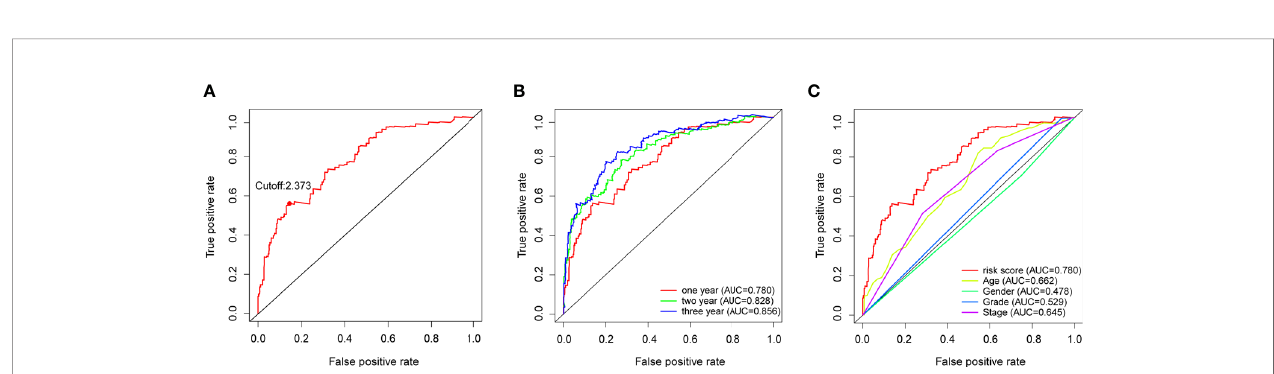
FIGURE 2 | Nineteen lncRNA pairs were subjected to univariate (A) and multivariate (B) Cox hazard analyses. Fourteen lncRNA pairs with p < 0.01 were included in the model.